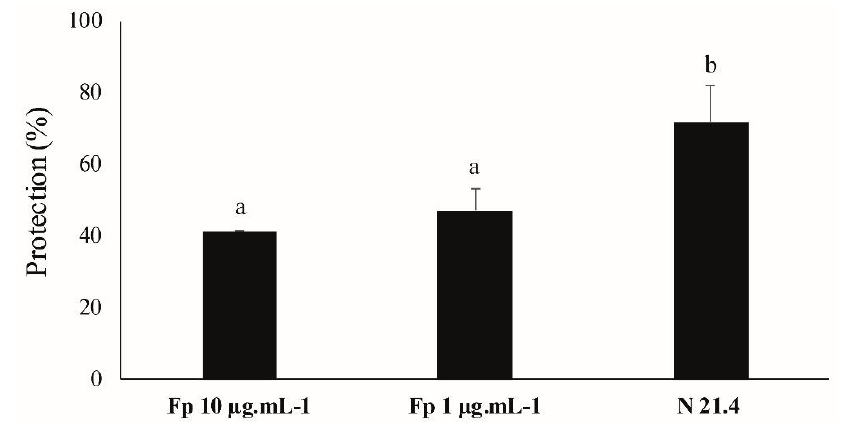
Figure 8. Protection (%) against Pseudomonas syringae pv. tomato DC3000 in Arabidopsis thaliana seedlings elicited with the purest fraction (Fp) at 10 and 1 µ g · mL − 1 and with the live strain P. fluorescens N 21.4. The percentage was calculated based on the number of leaves with disease symptoms to the total of leaves ( n = 12 seedlings per replicate). Data were relativized to control 1, which was considered as 0% protection. Di ff erent letters show significant statistical di ff erences between treatments ( p < 0.05). Error bars correspond to standard deviation (SD).